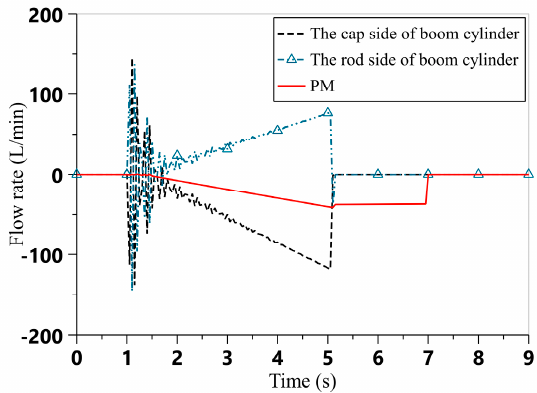
Figure 20. The flow rates of the boom cylinder and PM when the FFERS works in the energy recovery mode.